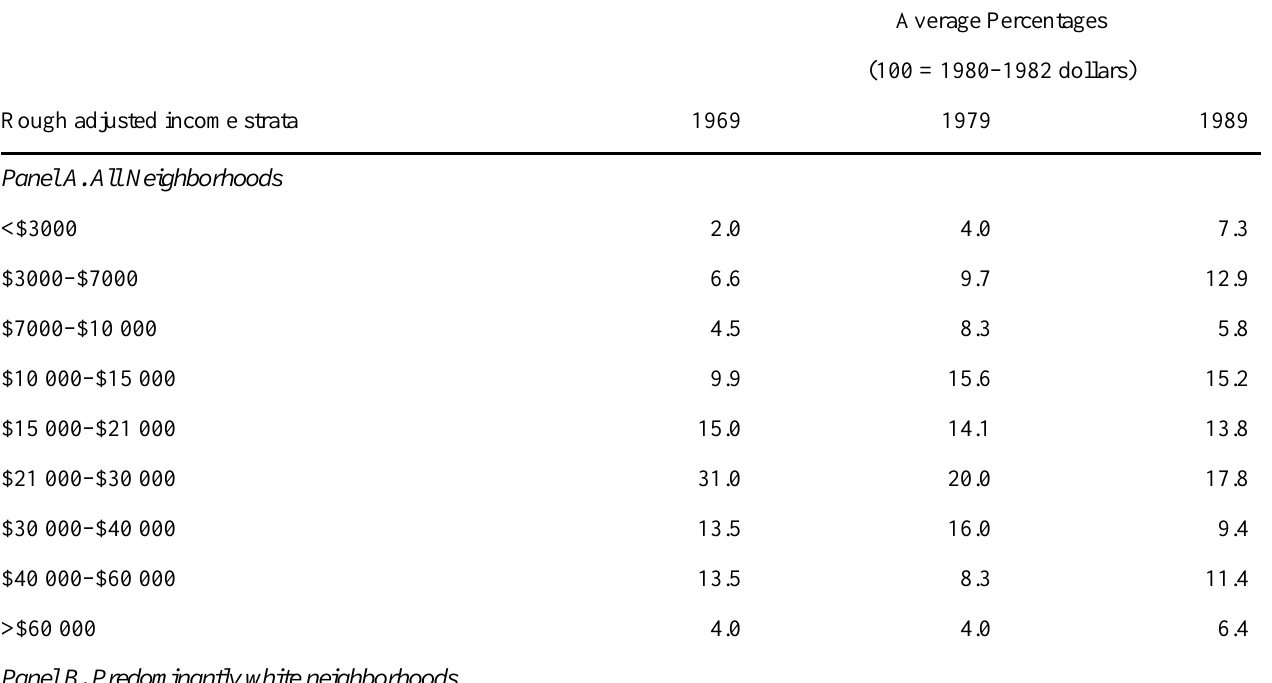
Table 12. Average percentages of households at various income levels by race: 1969, 1979, and 1989, Pittsburgh Standard Metropolitan Statistical Area Rough adjusted income strata 1969 1979